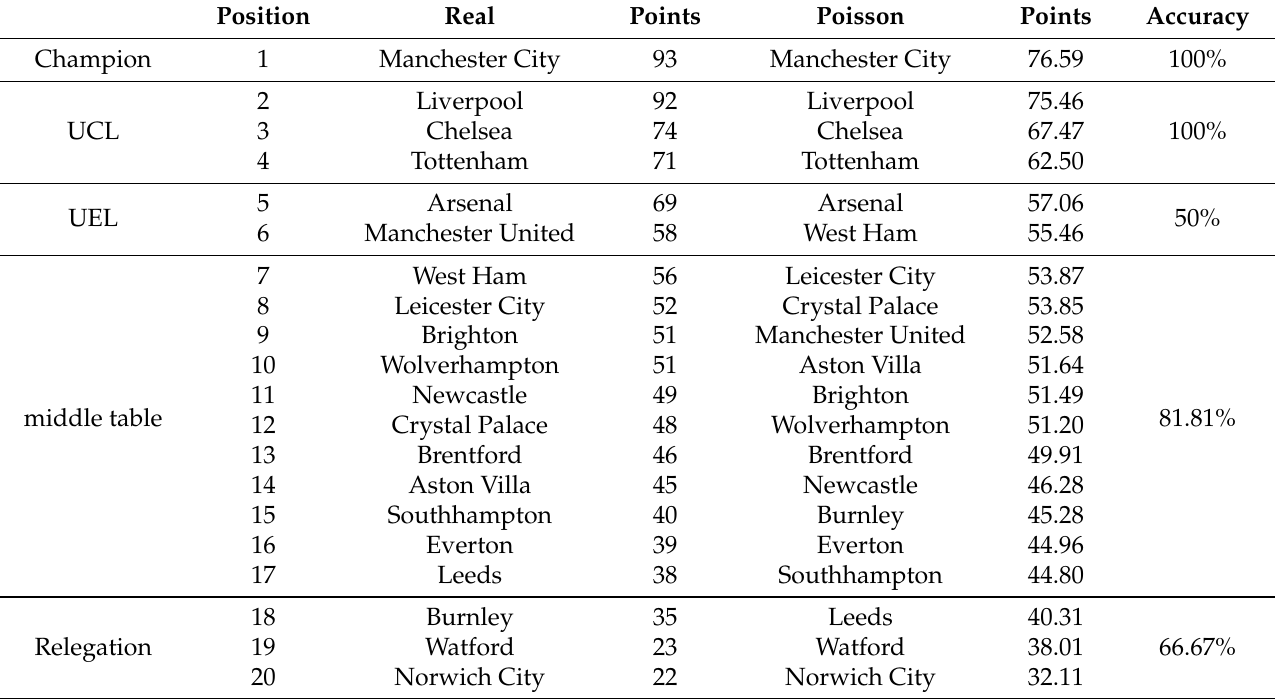
Table 5. Leader board